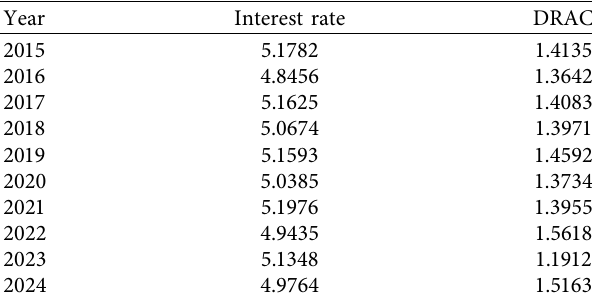
Table 3: DRACs for